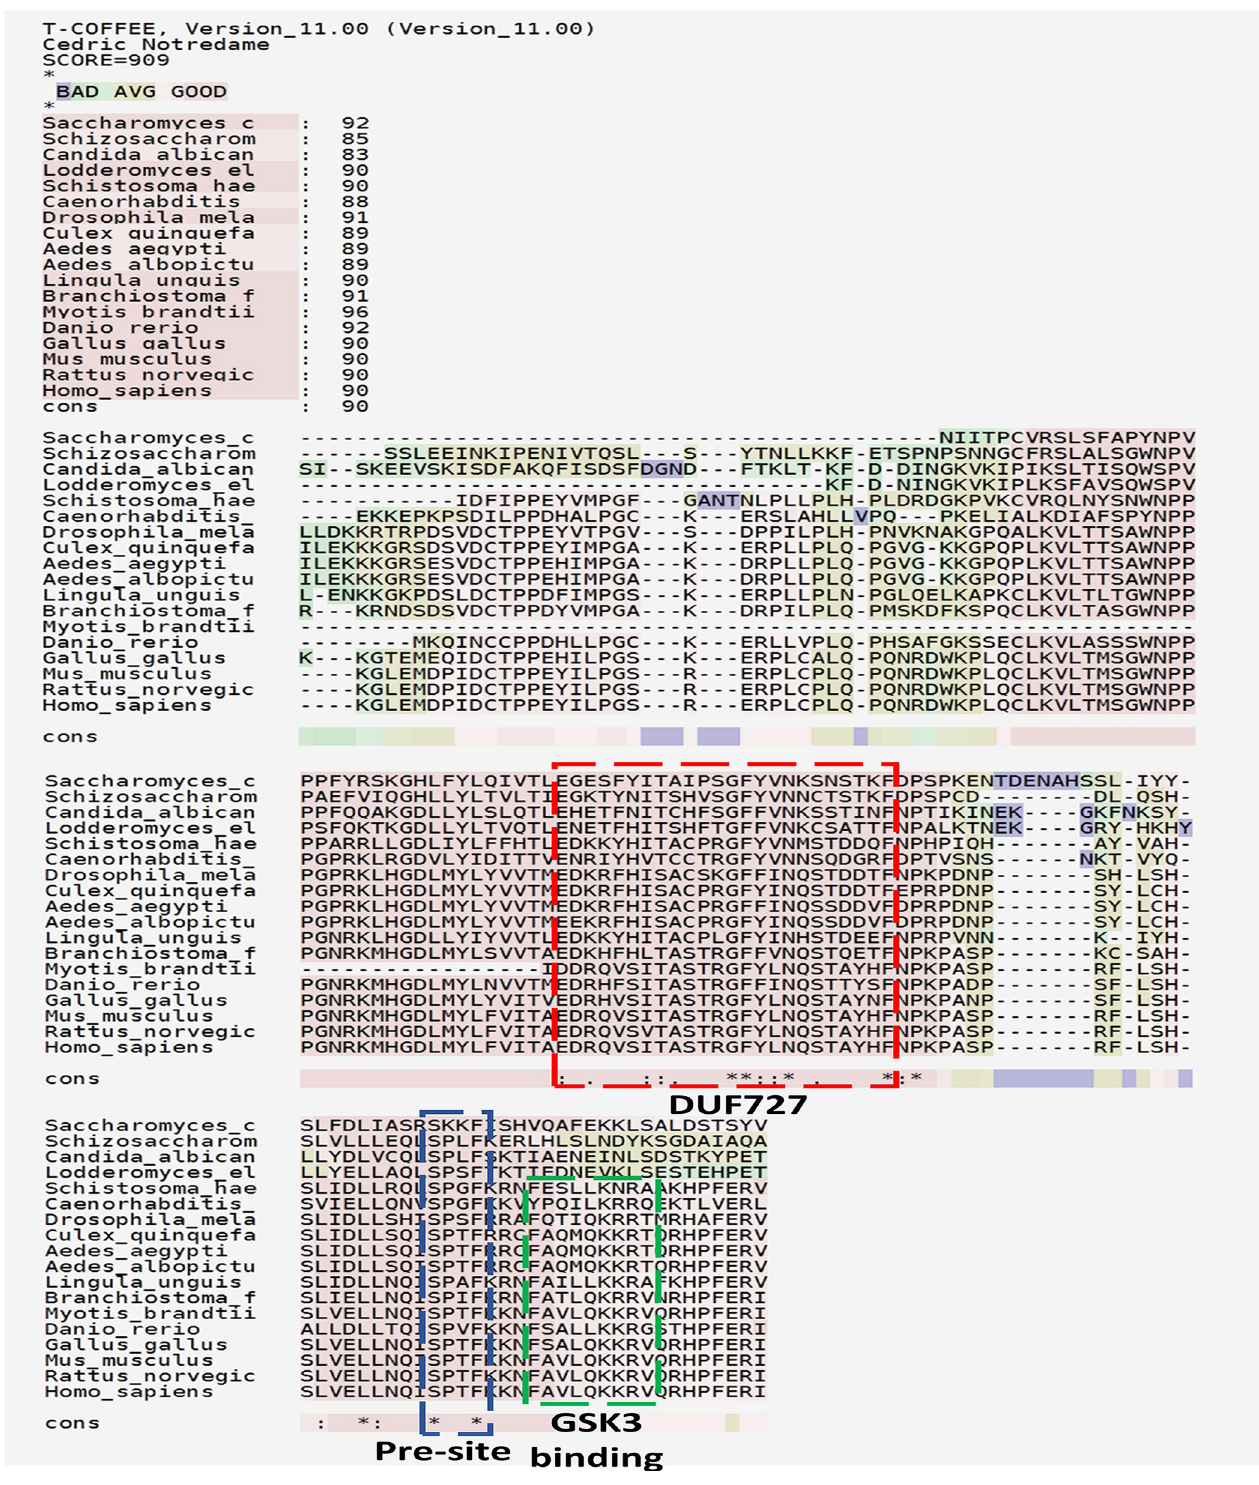
Fig 3. Sequence alignment of 20 composite-type GSKIP/CLU1 proteins among various species. Multiple sequence alignment with respect to the DUF727 region of GSKIP orthologs using T-Coffee. The conserved residues are indicated with asterisks, and residues with high similarity among the orthologs are marked with dots at the bottom. The 115SPxF118xxx122FxxxQxxRV130 motif in the pre-GSK3 β - and GSK3 β -binding regions is also indicated by blue and green boxes, respectively. T-Coffee also estimates alignment accuracy and improves phylogenetic tree reconstruction.